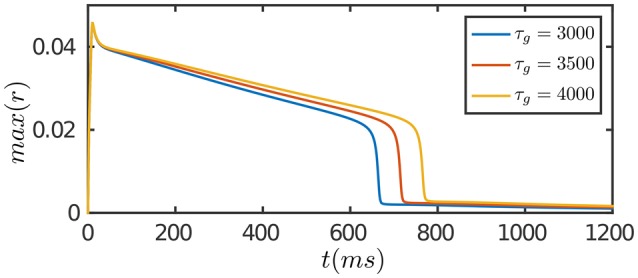
Adaptation of the network in response to a constant input. The input is given by Equation (8). The duration of adaptation, measured from the onset of stimulation to the moment the network activity fades away, is determined by the time scale of STD in feedforward connection, τg. Other parameters are the same as Figure 2.